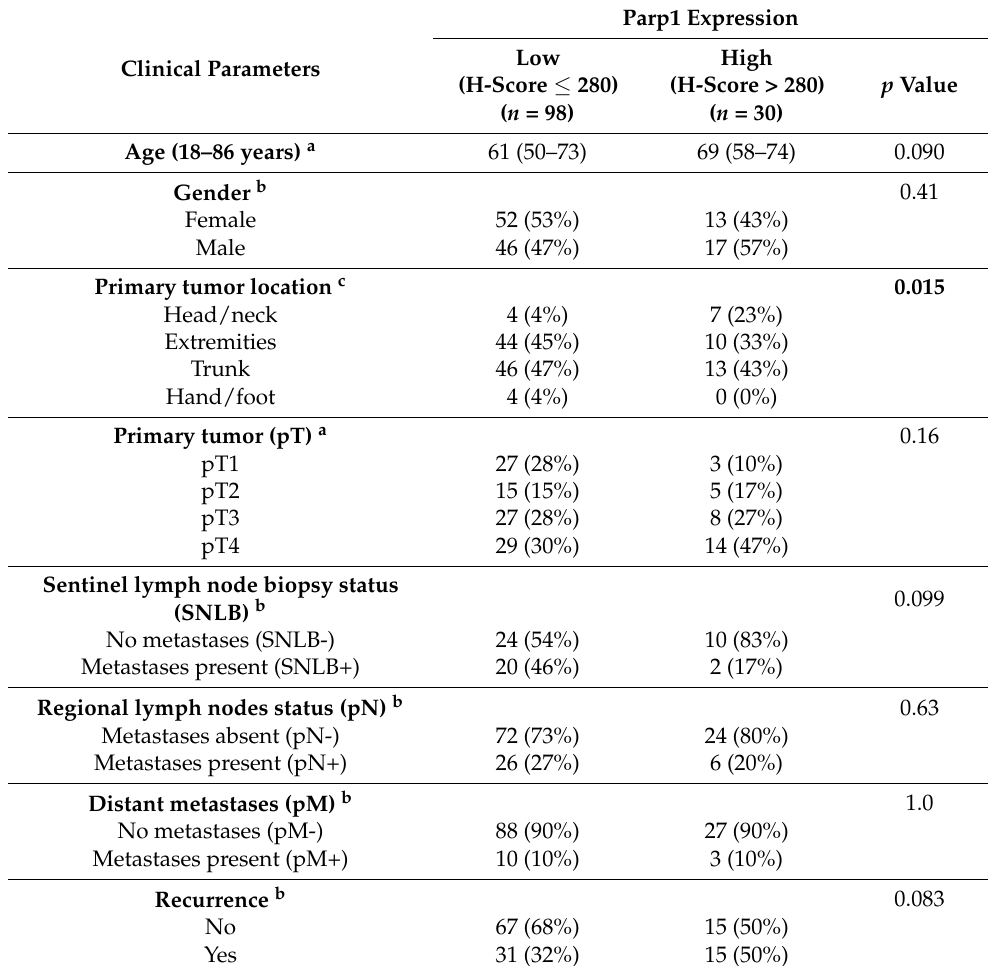
Table 2. Correlations between PARP1 expression and clinical parameters of cutaneous melanoma patients.